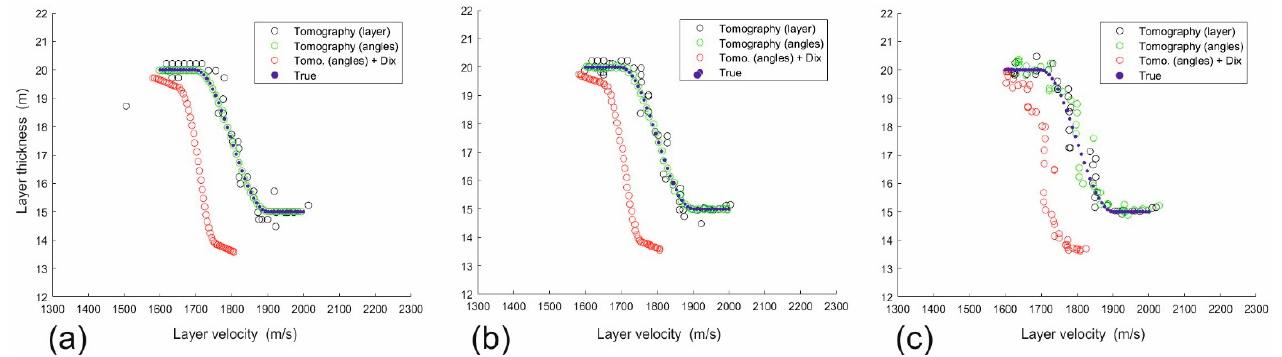
Figure 5. Median filtering of order 3 of the values in Figure 4, i.e., using tomography for layer parameters (black circles), angles (green circles) and with a Dix post-processing (red circles). The maximum error percentage in the travel times is the same as in Figure 3: none ( a ), 0.001% ( b ) and 0.01% ( c ).